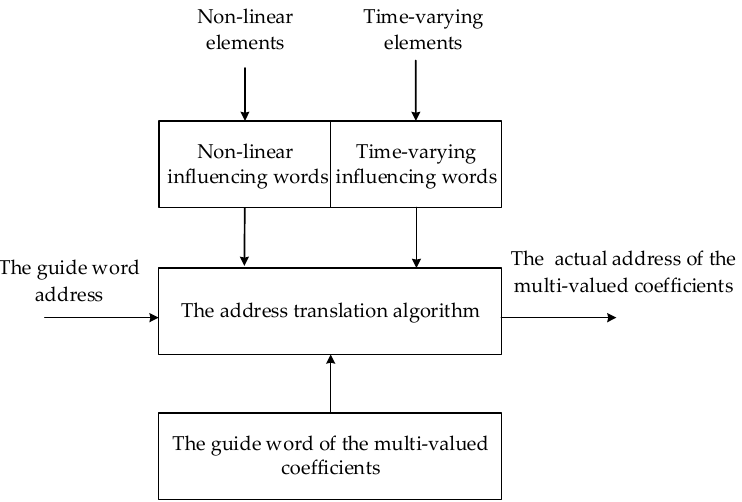
Figure 5. The address query circuit of the multivalued coefficients.